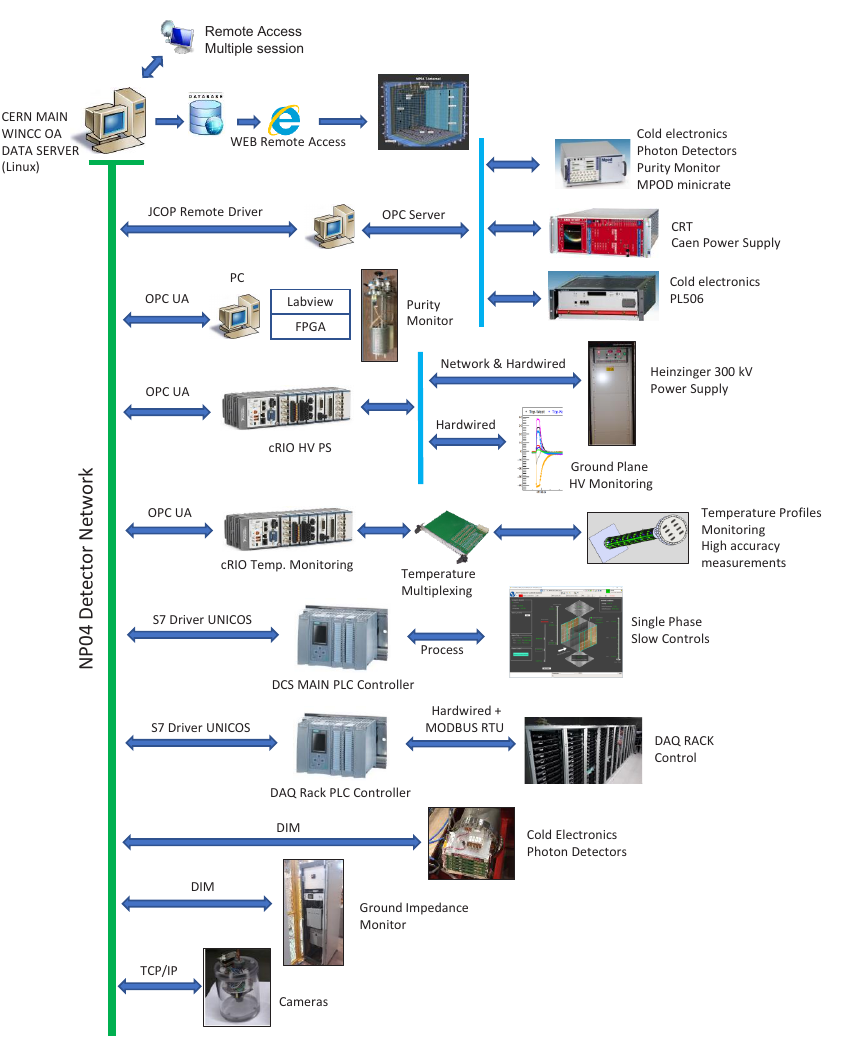
Figure 1. Diagram of the NP04 DCS topology. All the subsystems in the DCS are connected to a ded- icated network, the NP04 detector network. The DCS can communicate with each di ff erent